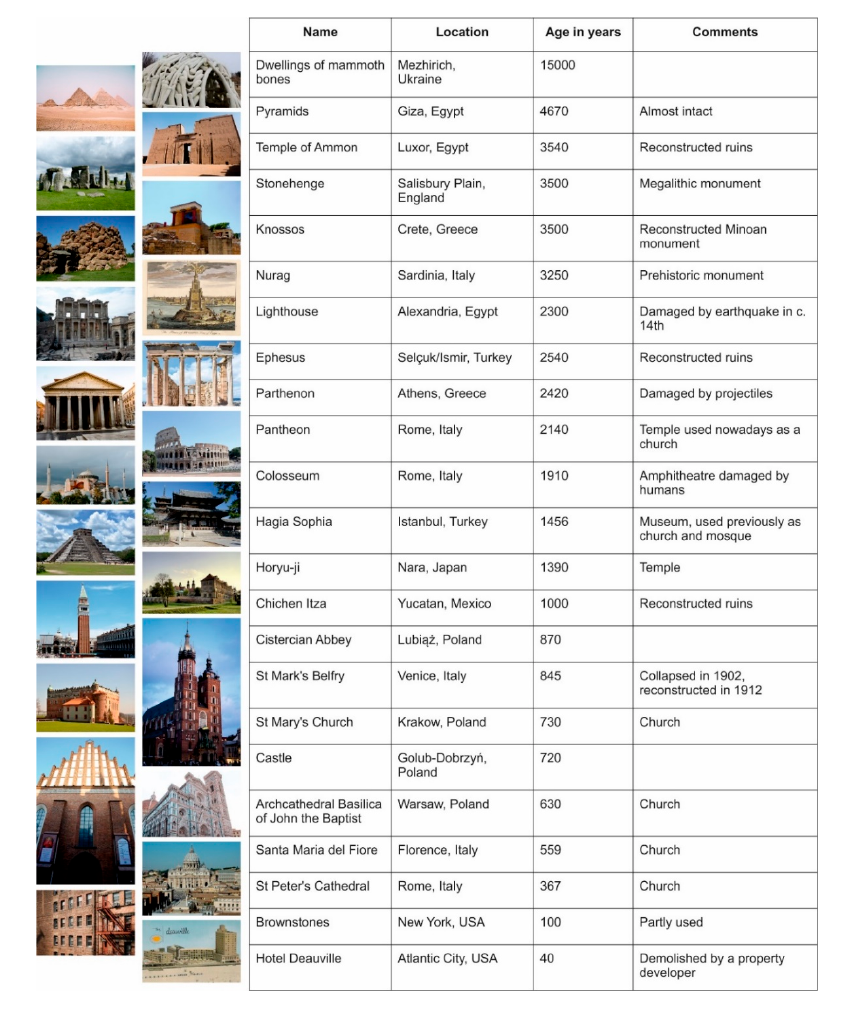
Figure 1. Selected monuments and their age [6], photo sources: unsplash.com, pxhere.com, pixabay.com, flickr.com, Wikipedia.com .